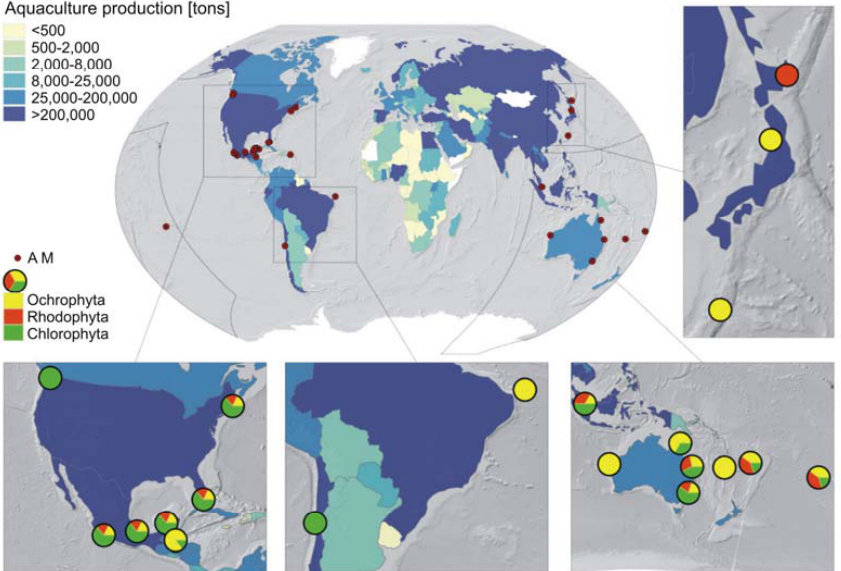
Figure 2. Allelopathic macroalgae (AM) in the studied areas based on the donor species found in